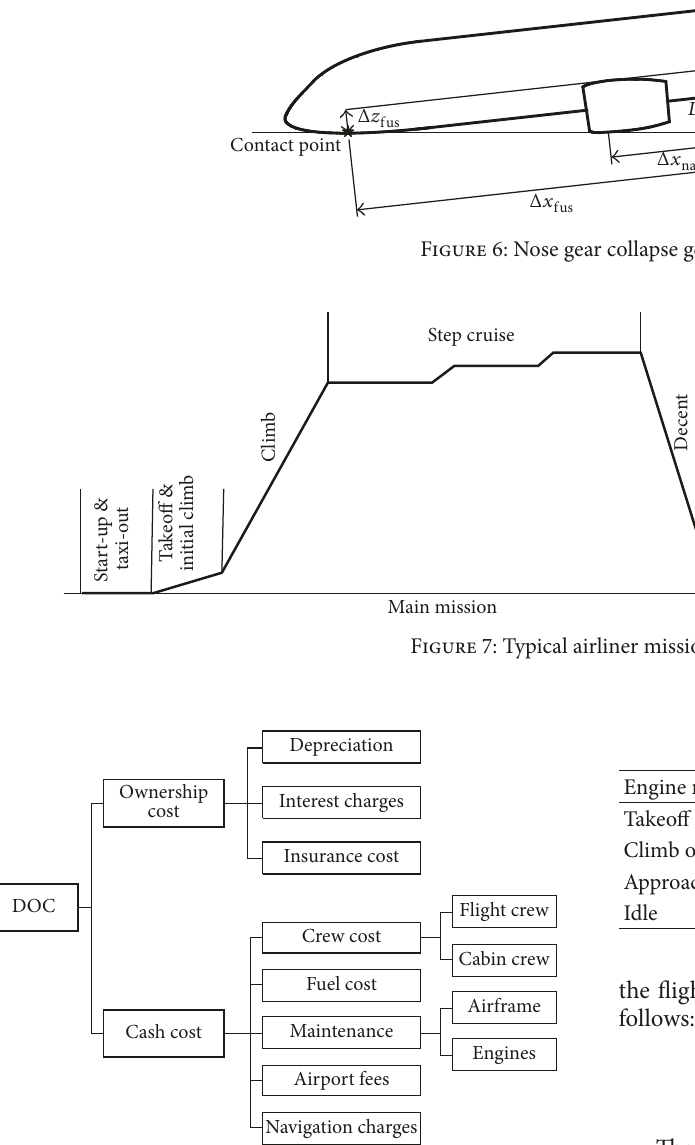
Figure 8: Direct operating cost components.